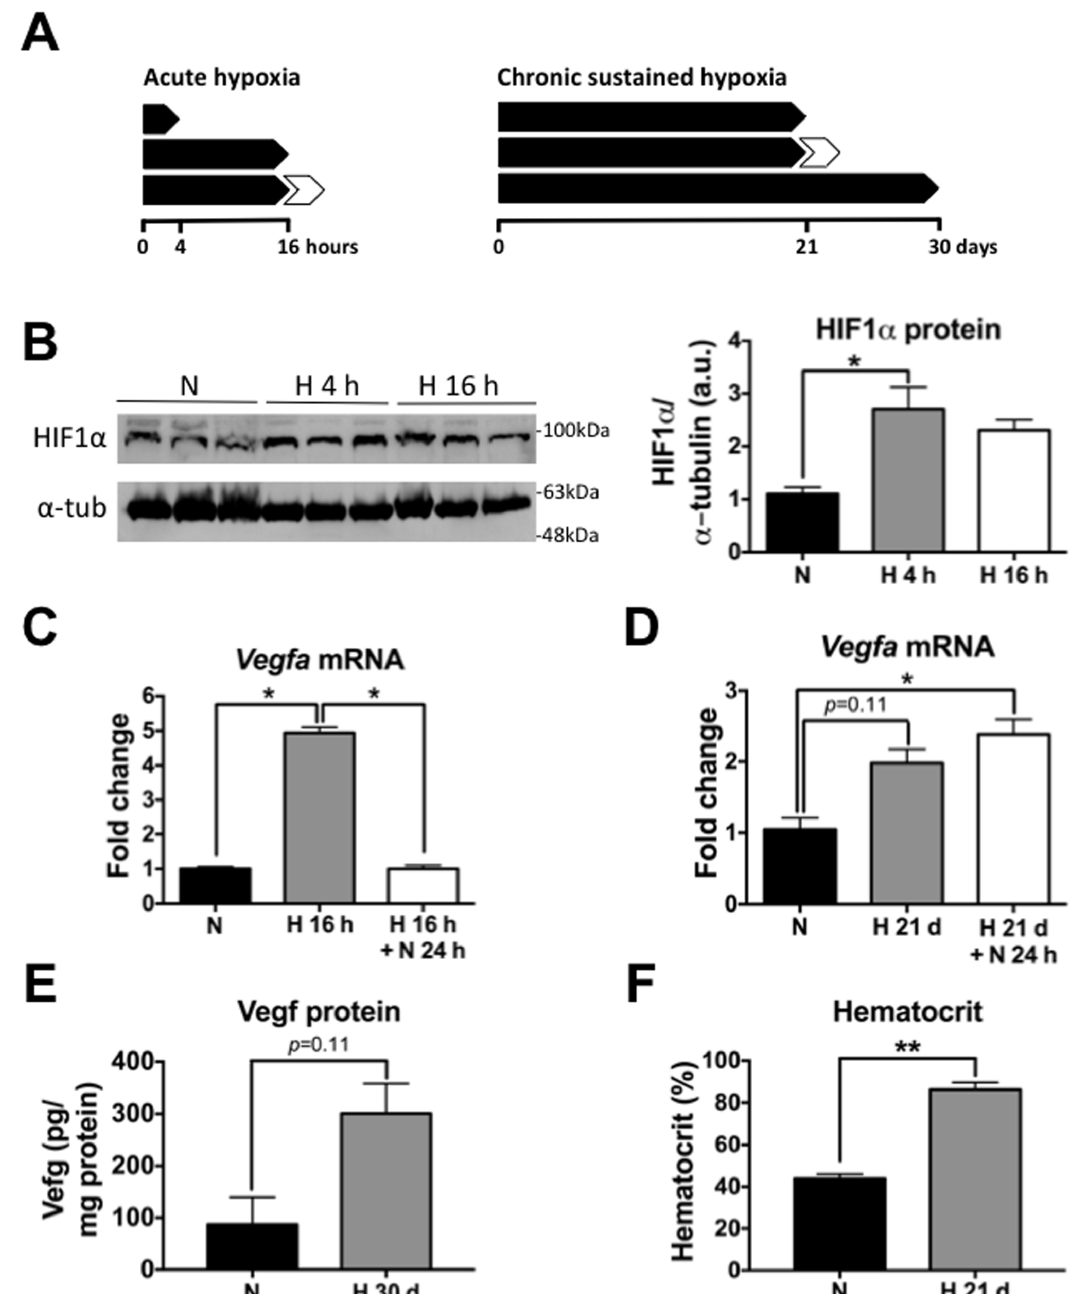
Fig 1. Characterization of hypoxia treatment protocols used in this study. (A) Schematic of acute ( top ) and chronic sustained( bottom ) hypoxiatreatment protocol used in this study. White arrowheadsrepresent reoxygenation (21% O 2 ) for 24 h. (B) Top , WB for HIF1 α in brain extracts from 2–3 month-oldwild-typemice subjectedto AH (9% O 2 ) for either 4 h or 16 h. Bottom , quantification of HIF1 α WB. p < 0.05; Kruskal-Wallis ANOVA with Dunn’smultiple comparison test, n = 3 per group. (C) Vegfa mRNA levels measuredby qRT-PCR in 2–3 month-old wild-typemice in normoxiaand after AH (9% O 2 ) for 16 h. Note the ~5-fold up-regulation of Vegfa expressioncaused by AH, which was reverted by 24 h reoxygenation. * p < 0.05; Kruskal-Wallis ANOVA with Dunn’smultiplecomparisontest, n = 4 per group. (D) Vegfa mRNA levels measured by qRT-PCR in 2–3 month-oldwild-typemice in normoxiaand after CSH (21 days, 9% O 2 ), with and without reoxygenation (24 h, 21% O 2 ). Note the ~2-fold up-regulation caused by CSH, which was not reverted by 24 h reoxygenation. * p < 0.05; Kruskal-Wallis ANOVA with Dunn’smultiplecomparisontest, n = 4 per group. (E) Vegf protein levels were measuredby ELISA in 2–3 month-oldwild-typemice subjectedto either CSH (30 days, 9% O 2 ) or